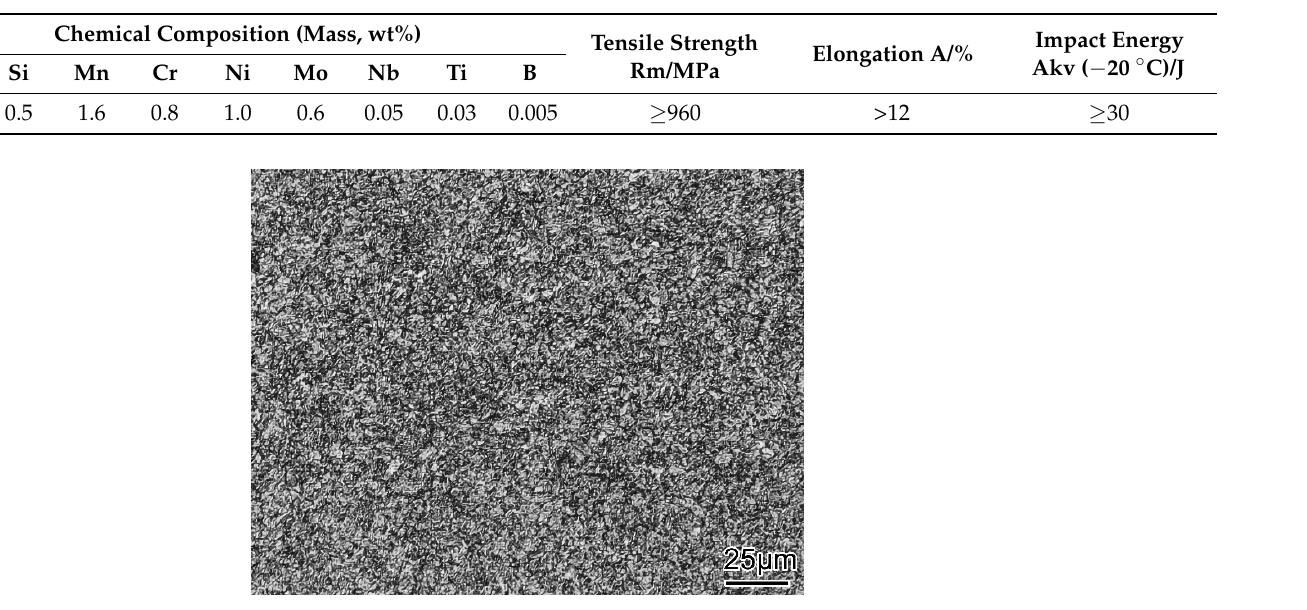
Table 1. Chemical composition and mechanical properties of Q960 steel.